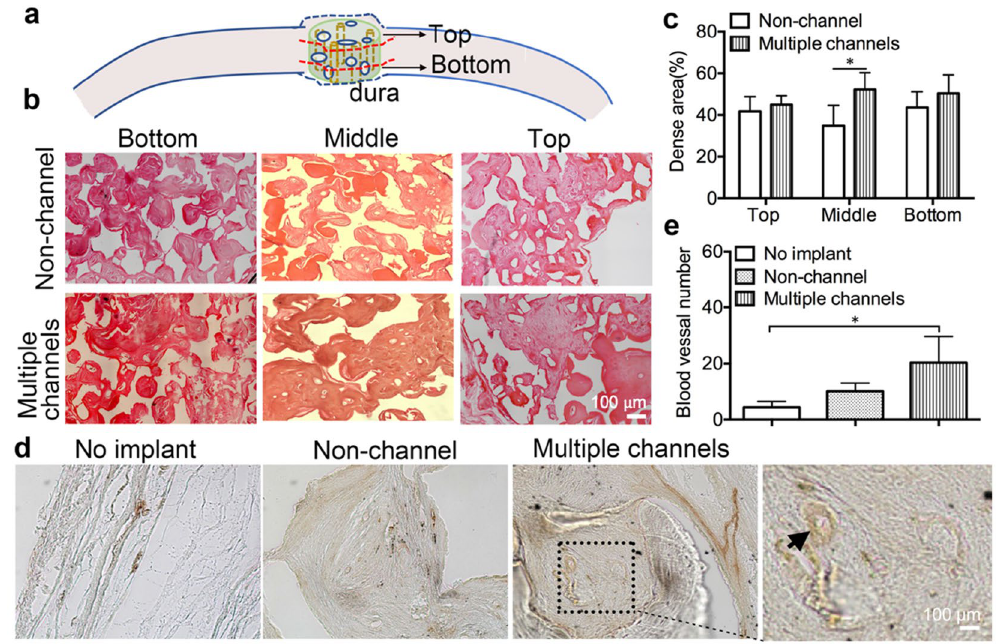
Figure 7. In vivo characterization: ( a ) schematic graph shows the three layers for cut sections of the implants when the embedded scaffolds were cut on a microtome. ( b ) H&E staining shows the structure of newly formed bone in the three layers of the two types of scaffolds. ( c ) Quantitative results of the dense area of new bone in the three different layers of the scaffolds. ( d ) Immunohistochemical staining of CD31 on the explants. ( e ) Quantitative results of the blood vessel number in the three groups based on the immunohistochemical images. (n = 3, * p <